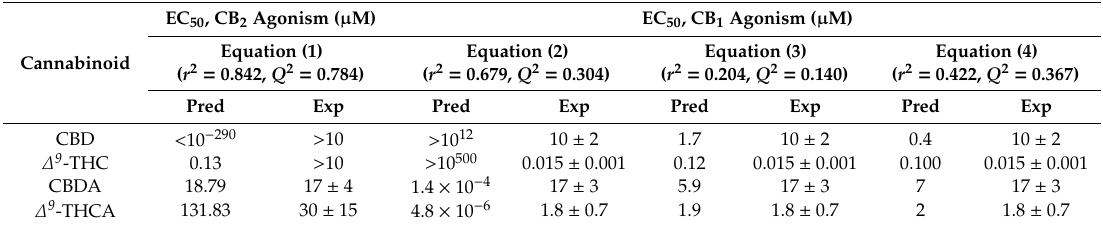
Table 4. Predicted and experimental EC 50 values for four major phytocannabinoids at CB 1 and CB 2 receptors. Generally, a di ff erence of less than 0.2 between r 2 and Q 2 is indicative of good predictive power for models. Note: Pred—Predicted,